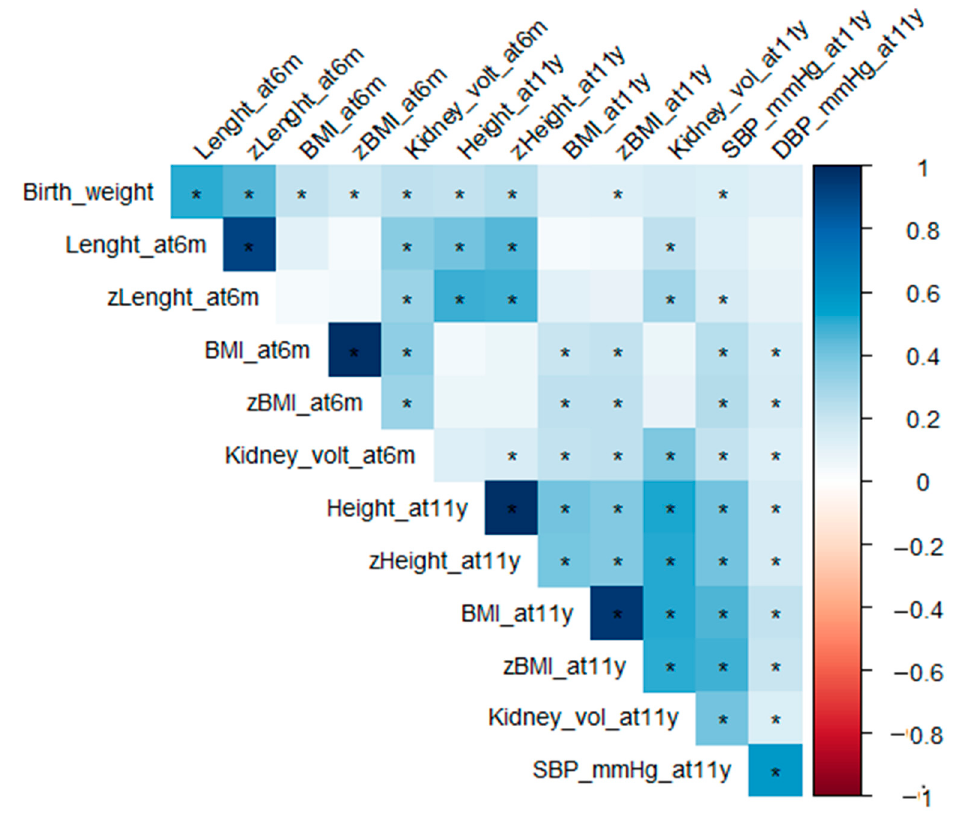
Figure 1. Correlation between variables. Spearman’s correlation coefficients among variables. * p < 0.05.